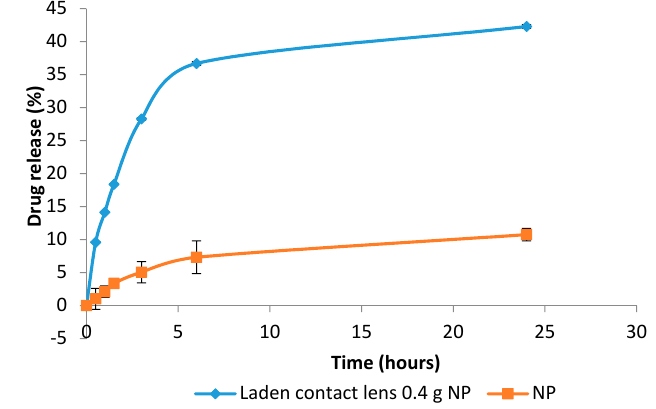
Figure 12. Drug release pattern of nanoparticles (NP) alone and contact lenses loaded with 0.4 g of nanoparticles over 24 h.